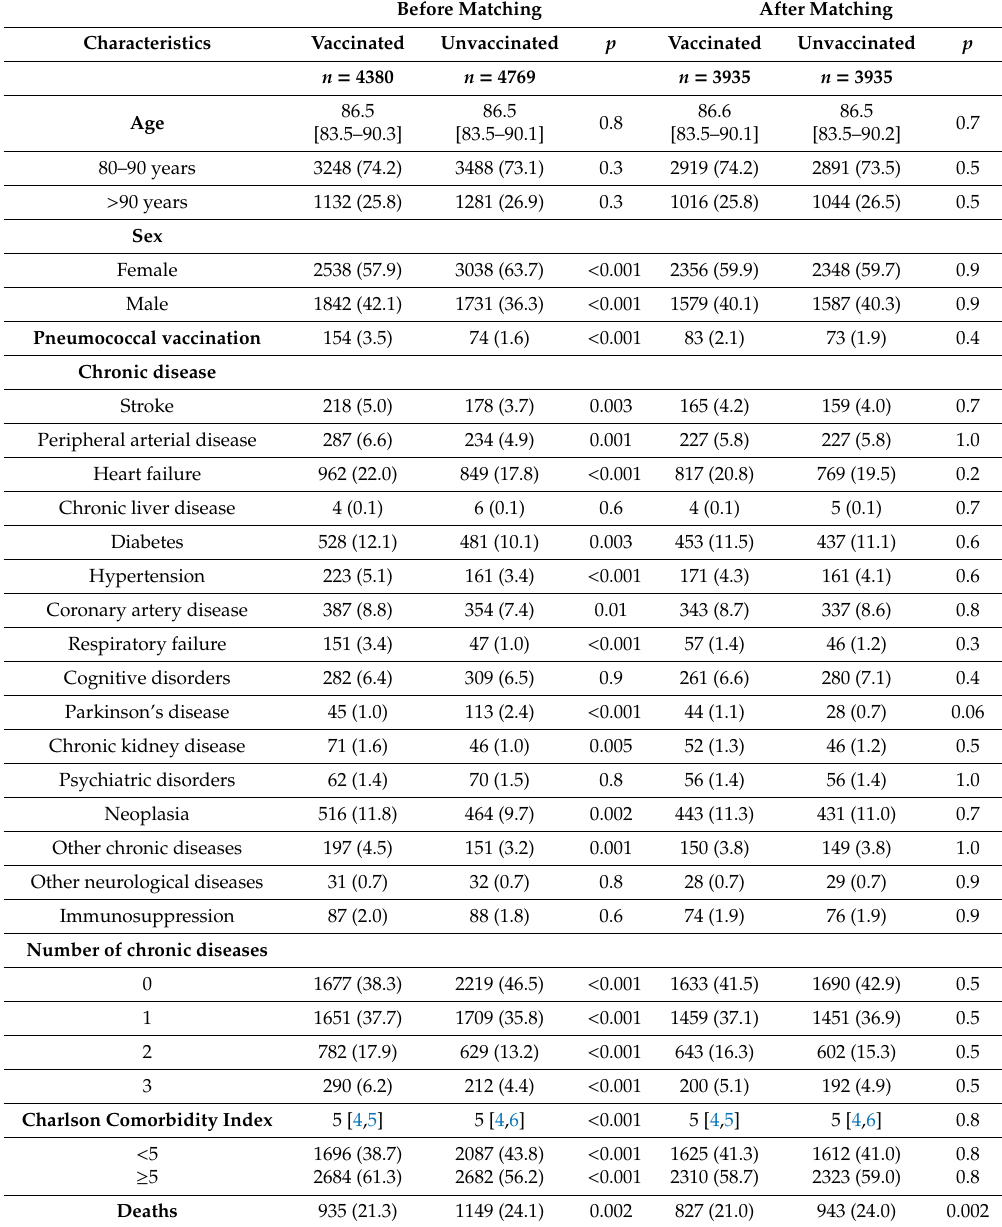
Table 1. Comparison of vaccinated and unvaccinated subjects against influenza before and after matching. Before Matching After Matching